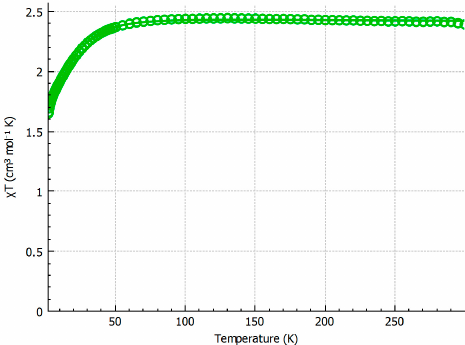
Figure 3. Thermal variation of χ m T for 1 between 300 and 2 K with 1000 Oe (0.1 T). Solid line shows the best fit to the model (see text).